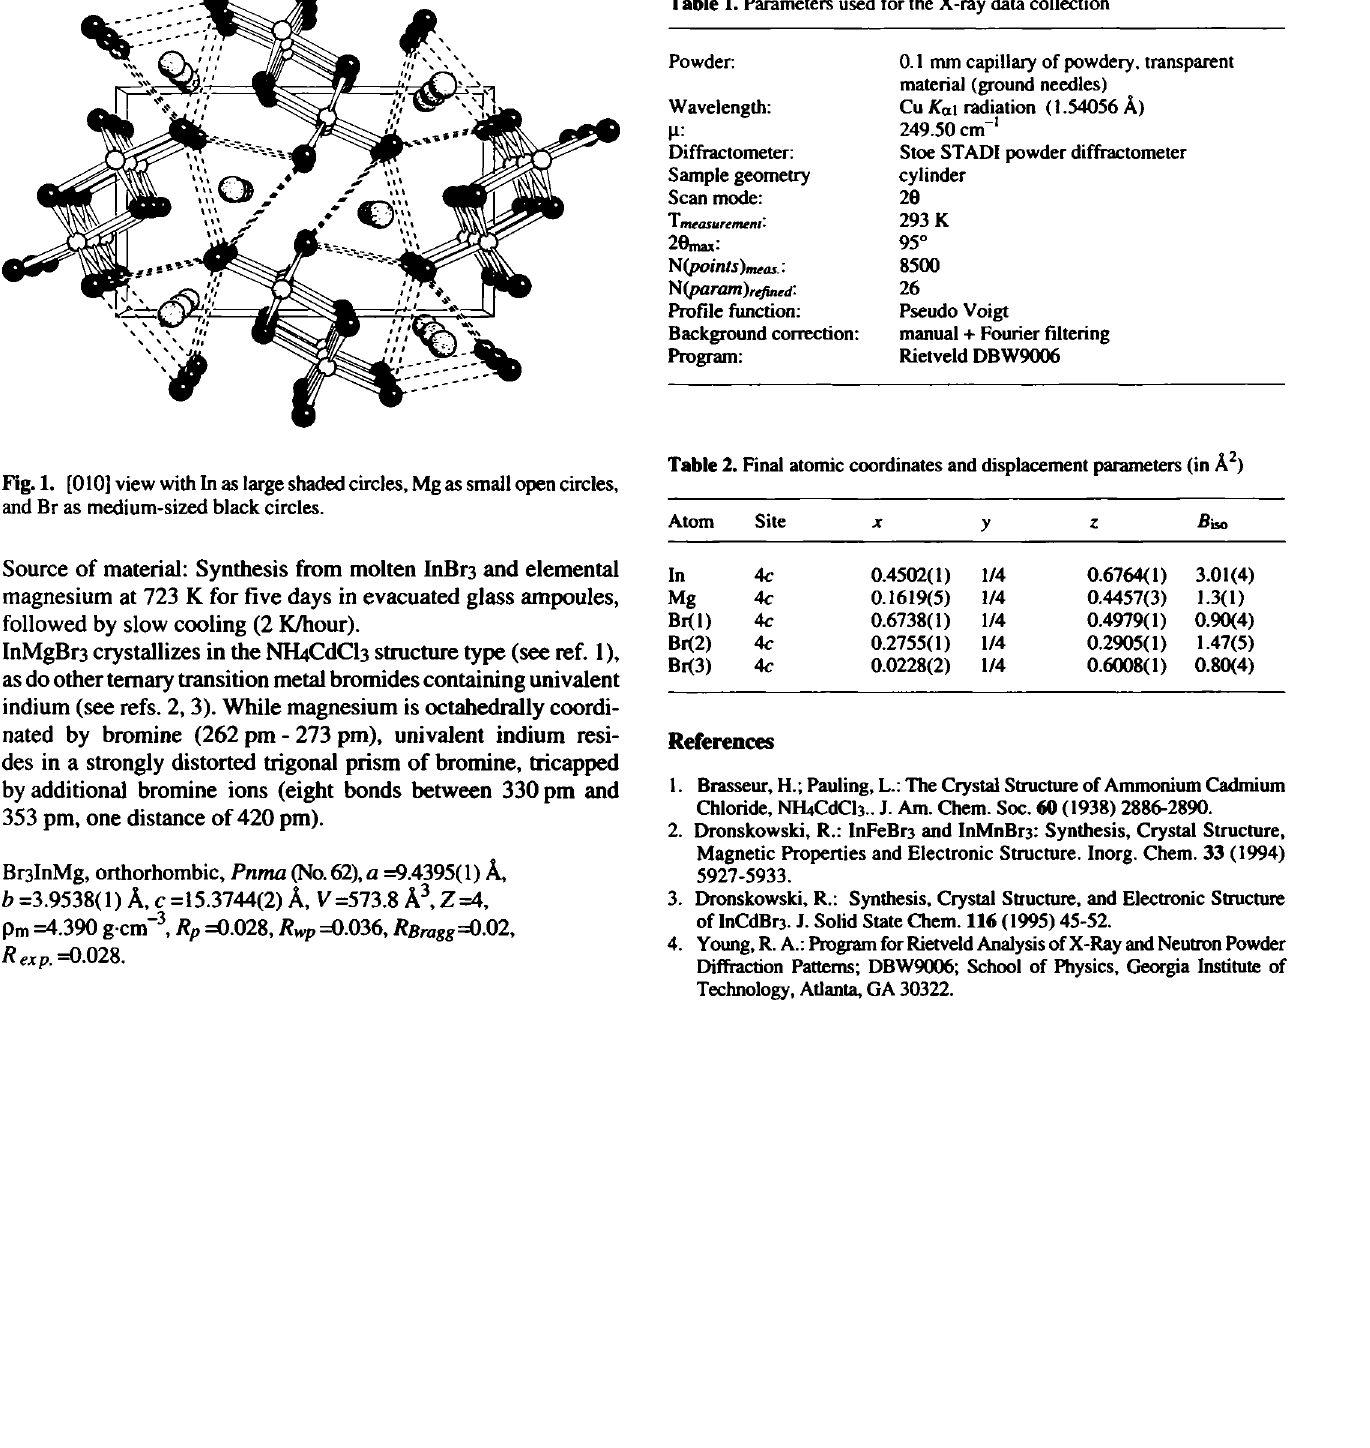
Table 1. Parameters used for the X-ray data collection